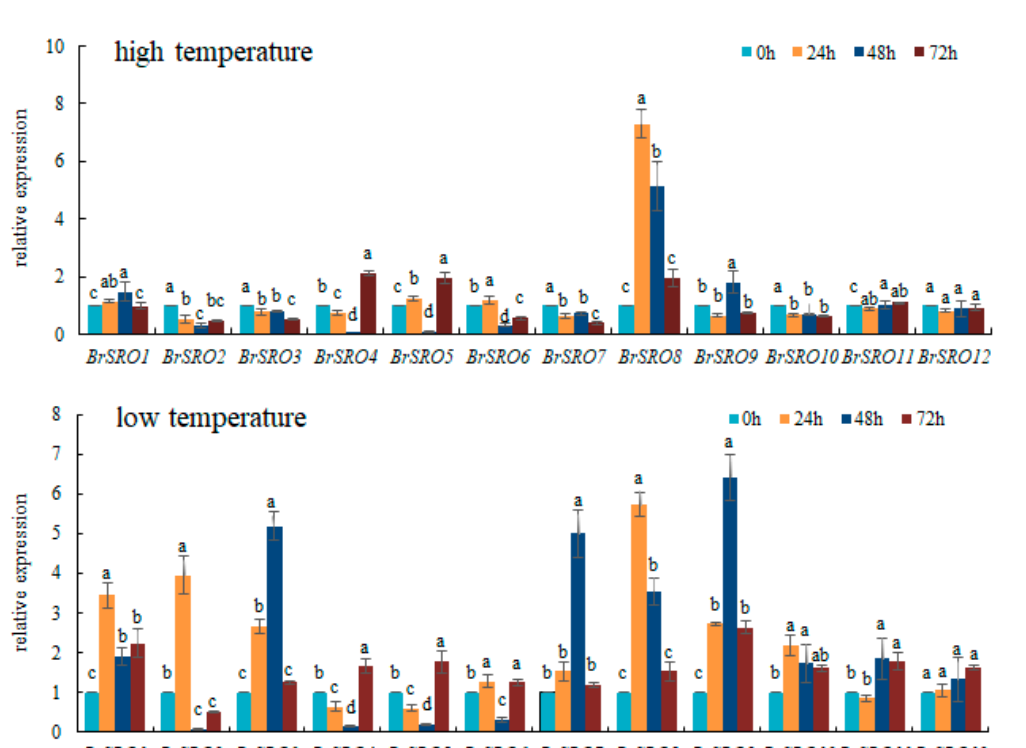
Figure 5. Expression profiles of 12 BrSRO genes in response to high temperature treatment, low- temperature treatment, drought treatment, and salt treatment. Quantitative reverse transcription polymerase chain reaction (qRT-PCR) analyses were used to assess the transcript levels of BrSROs in leaves sampled at 24 h, 48 h and 72 h after high temperature, low-temperature treatment, drought, and salt treatment in Chinese cabbage seedlings. 0 h as control. Three sets of repeats are set for each process. Error bars indicate standard deviations of three replicates and different letters describe significant differences at p ≤ 0.05 level among different time points within the same gene.